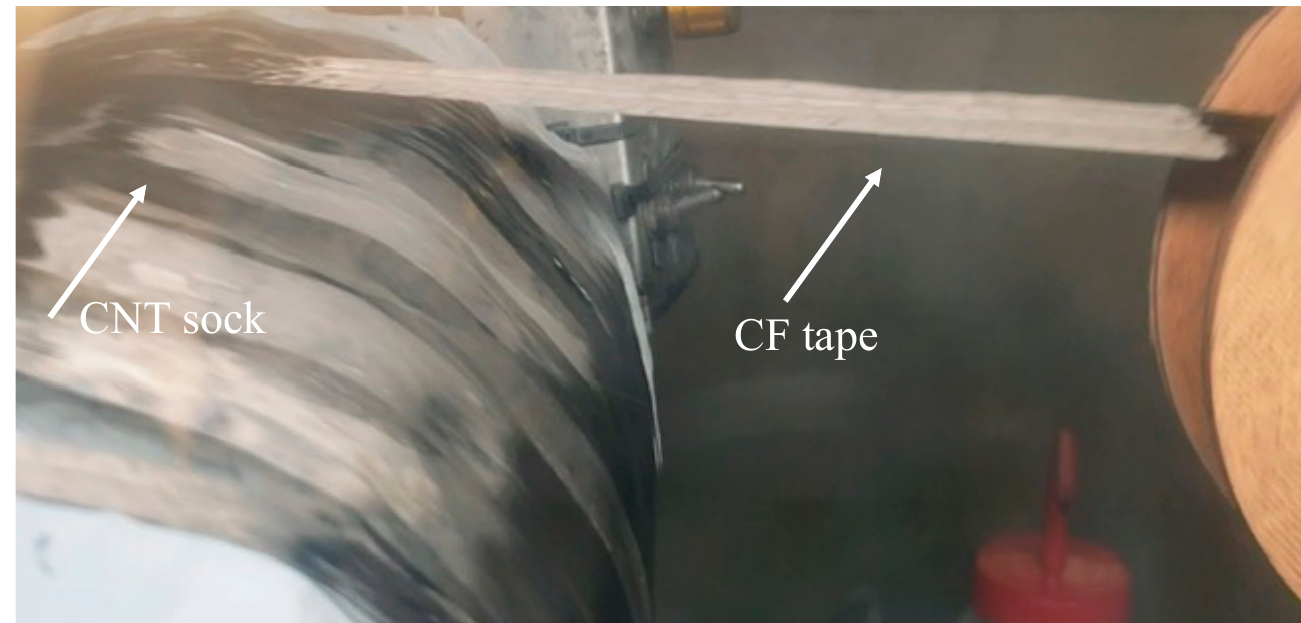
Figure 3. Winding drum used at the outlet for simultaneous wrapping of CNT and carbon fiber (CF) spread tow high modulus (HM) tape to make strong and stiff CHM.